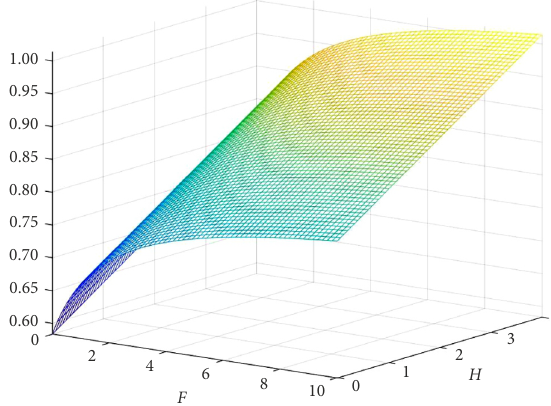
Figure 11. The area of ABCD